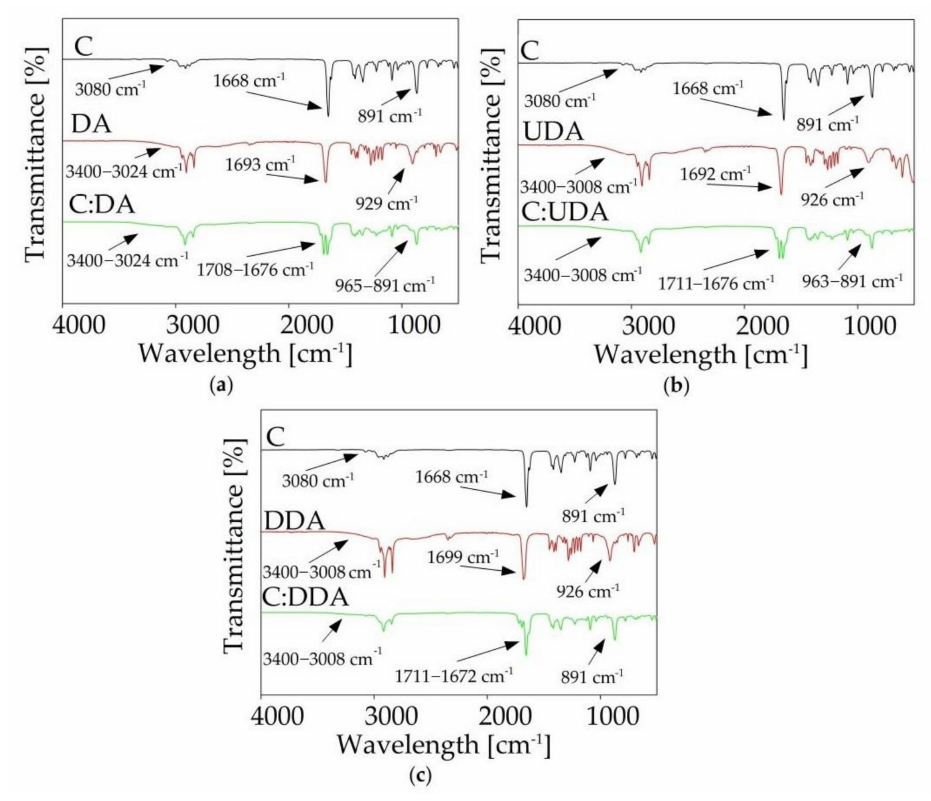
Figure 6. FT-IR spectra of pure components (HBA and HBD) and synthesized DES: ( a ) C:DA (1:1), ( b ) C:UDA (1:1), ( c ) C:DDA